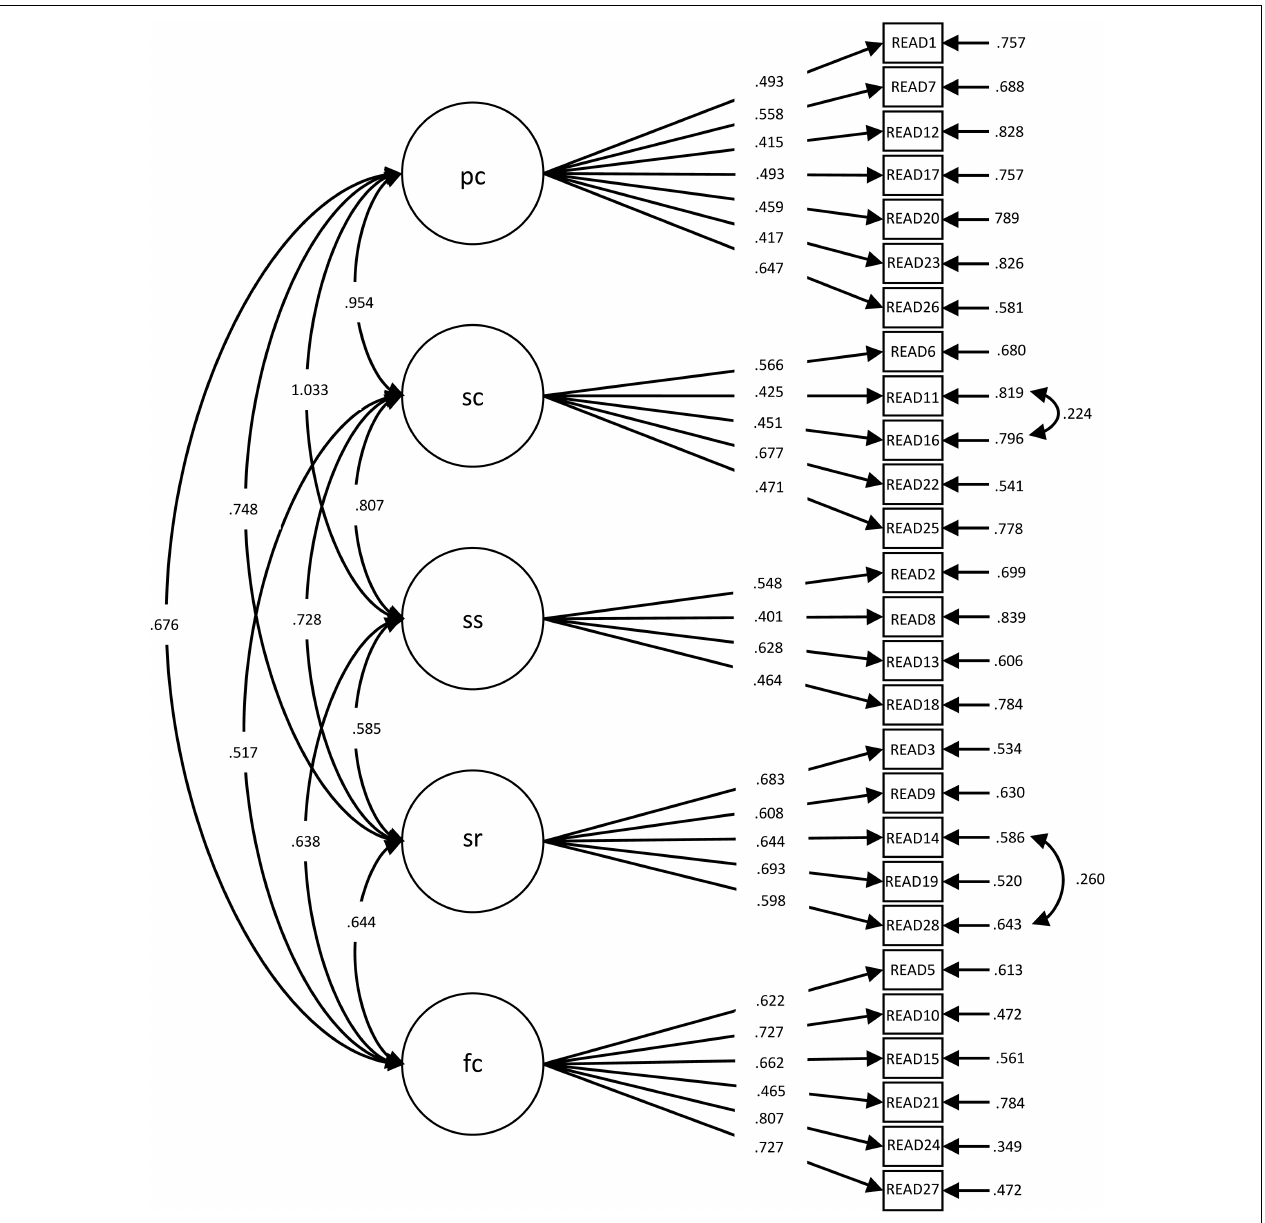
FIGURE 1 | Factor loadings for the five-factor, 27-item model (Germany: N = 321). pc, personal competence; sc, social competence; ss, structured style; sr, social resources; fc, family